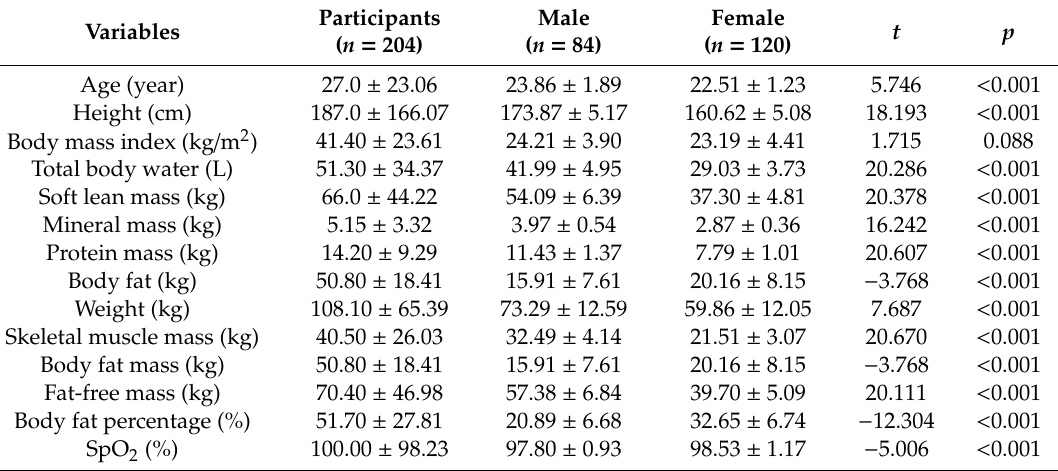
Table 3. General characteristics of the